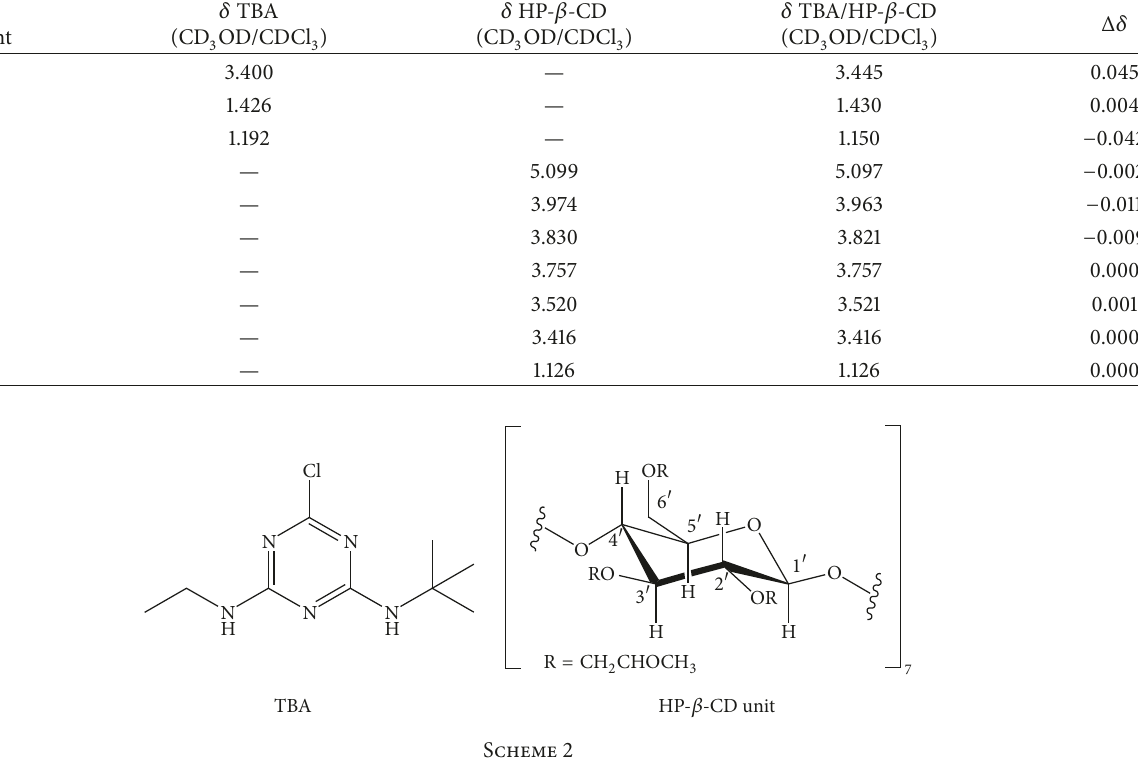
Table 3: 1 H NMR chemical shift ( 𝛿 ) data of TBA, HP- 𝛽 -CD, and TBA/HP- 𝛽 -CD complex (see Scheme